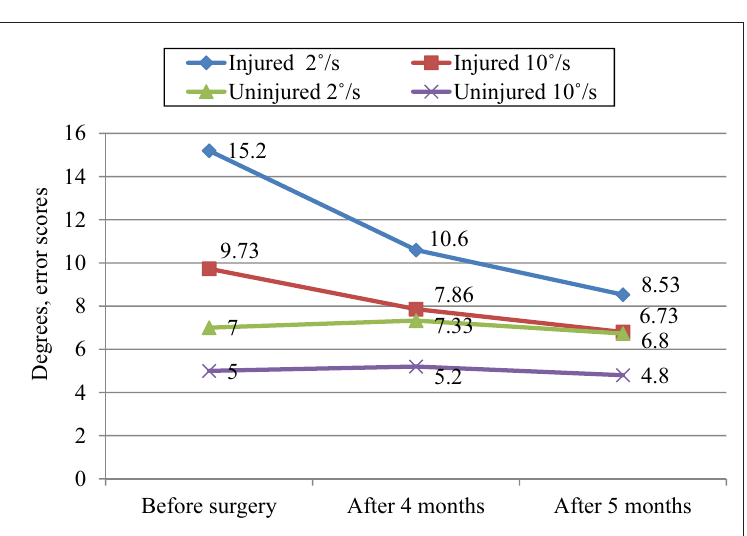
Figure 2. Mean values of uninjured and injured knee flexion at different velocities (p <